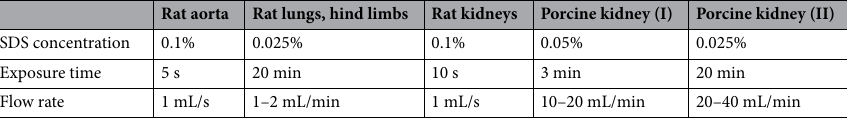
Table 1. Selected decellularization regimens.